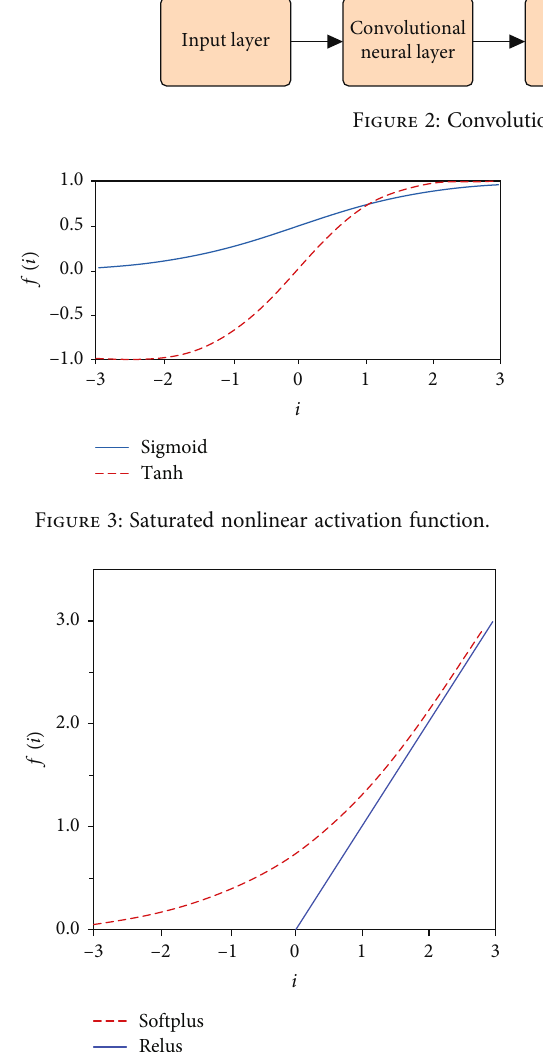
Figure 4: Unsaturated nonlinear activation function.